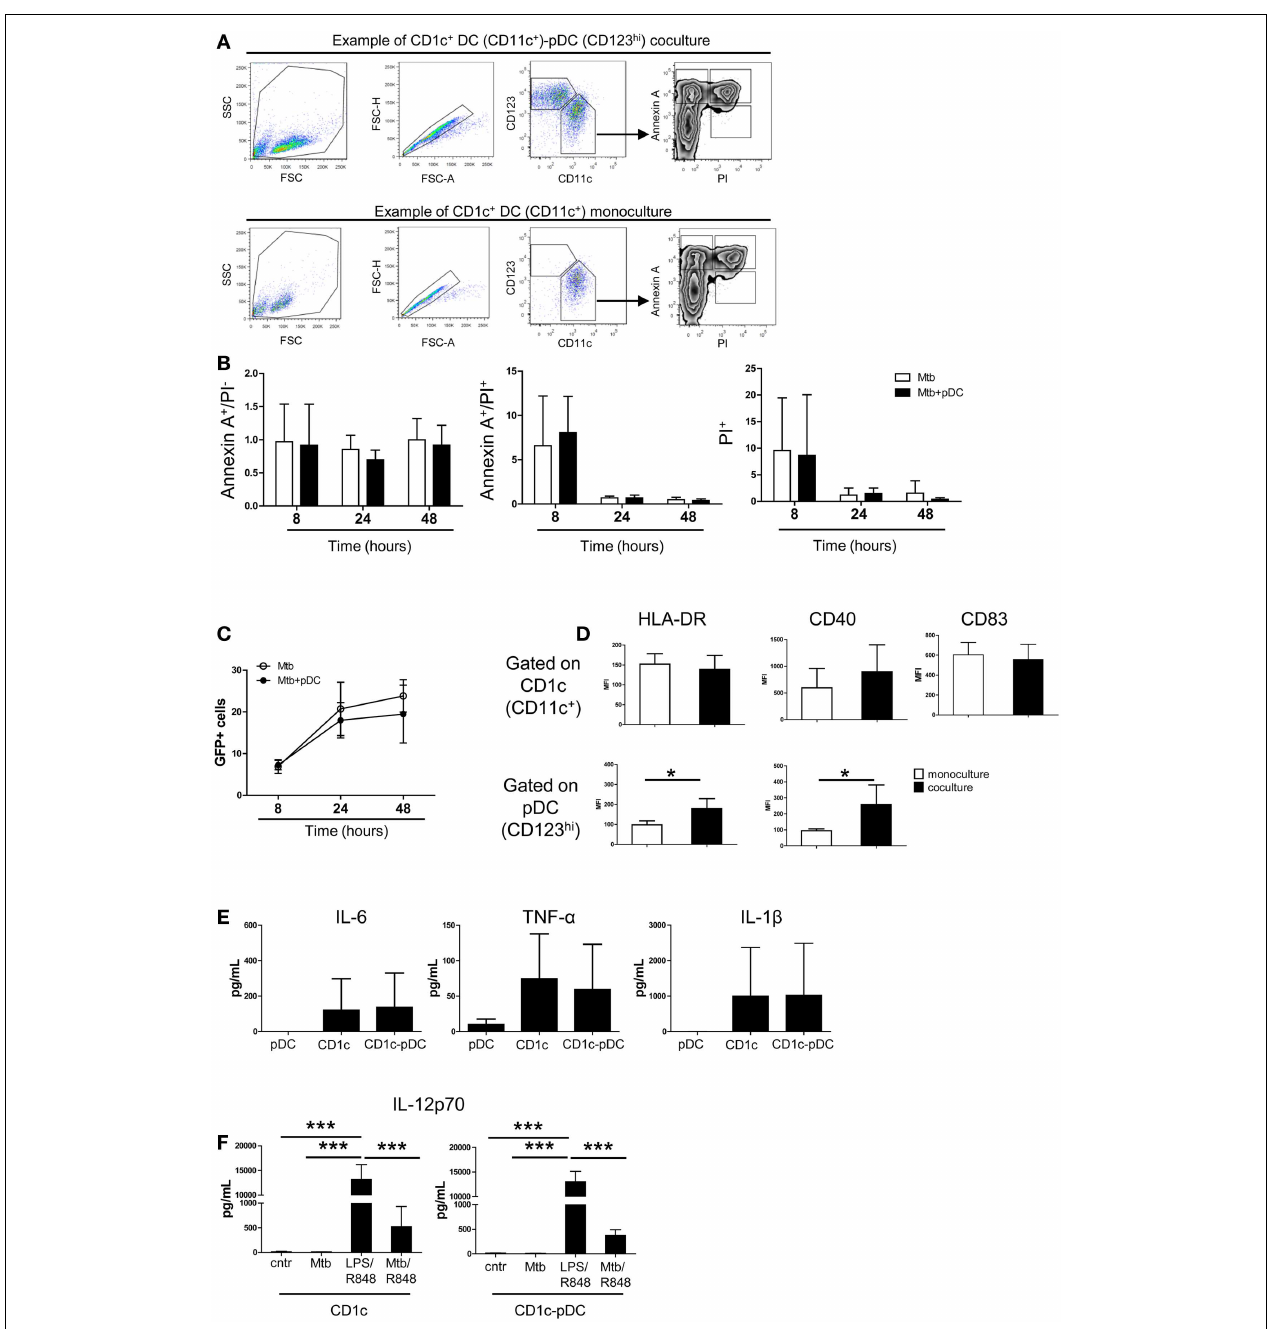
absence of Mtb). (C) Percentage of Mtb-infected (GFP + )-CD1c + DCs in the presence or absence of pDCs. (D) Mean fluorescence intensity of HLA-DR, CD40, and CD83 in Mtb-infected mono- (white bars) or co-cultures (black bars) gated on CD1c + DCs (top) or pDCs (bottom panel) (Mann–Whitney test). (E) Cytokine production by pDCs, CD1c + DCs, or CD1c-pDC cultures 16h post-infection. (F) Production of IL-12p70 by CD1c + DC or CD1c + DC-pDC cultures 16h post-infection in the absence (Mtb) or in the presence (Mtb/R848) ofTLR7/8 ligands or after stimulation withTLR4 andTLR7/8 ligands (LPS/R848). Control (Cntr) indicated unstimulated cells. Data are obtained from six donors in two independent experiments. One-way ANOVA; * p < 0.05, *** p <